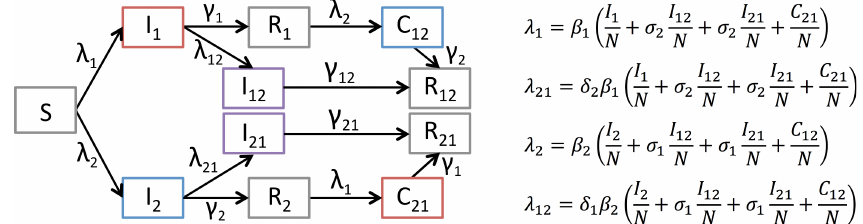
Fig 3. Illustration of a simple model of two circulating pathogens in interactions. Schematic of the compartments and rates of transition between compartments, with equations of the forces of infection by pathogen 1 ( λ 1 ), pathogen 2 ( λ 2 ) for susceptible hosts, and pathogen 1 ( λ 21 ) and pathogen 2 ( λ 12 ) for hosts already infected by the other pathogen. The full system of ordinary differential equations describing the changes of the compartment’s populations over time is described in S1 Appendix, section B. Details of the model and parameters are provided in Box